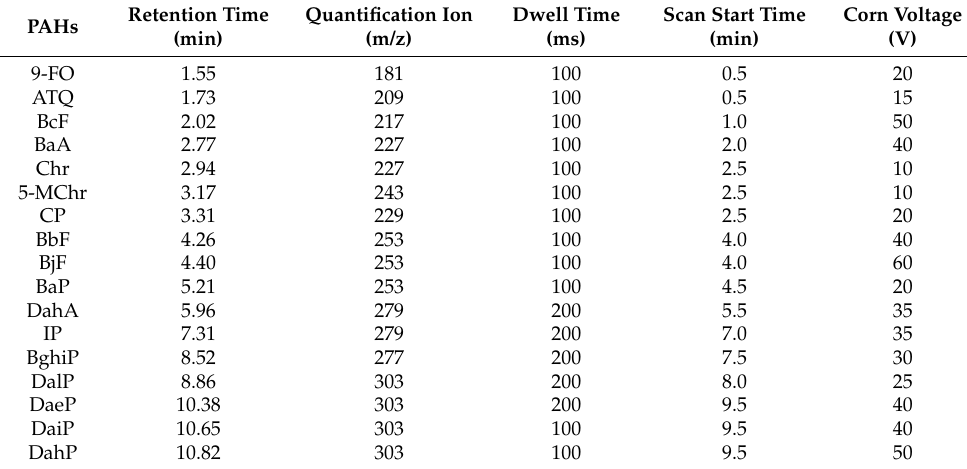
Table 1. SIM parameters of target analytes using